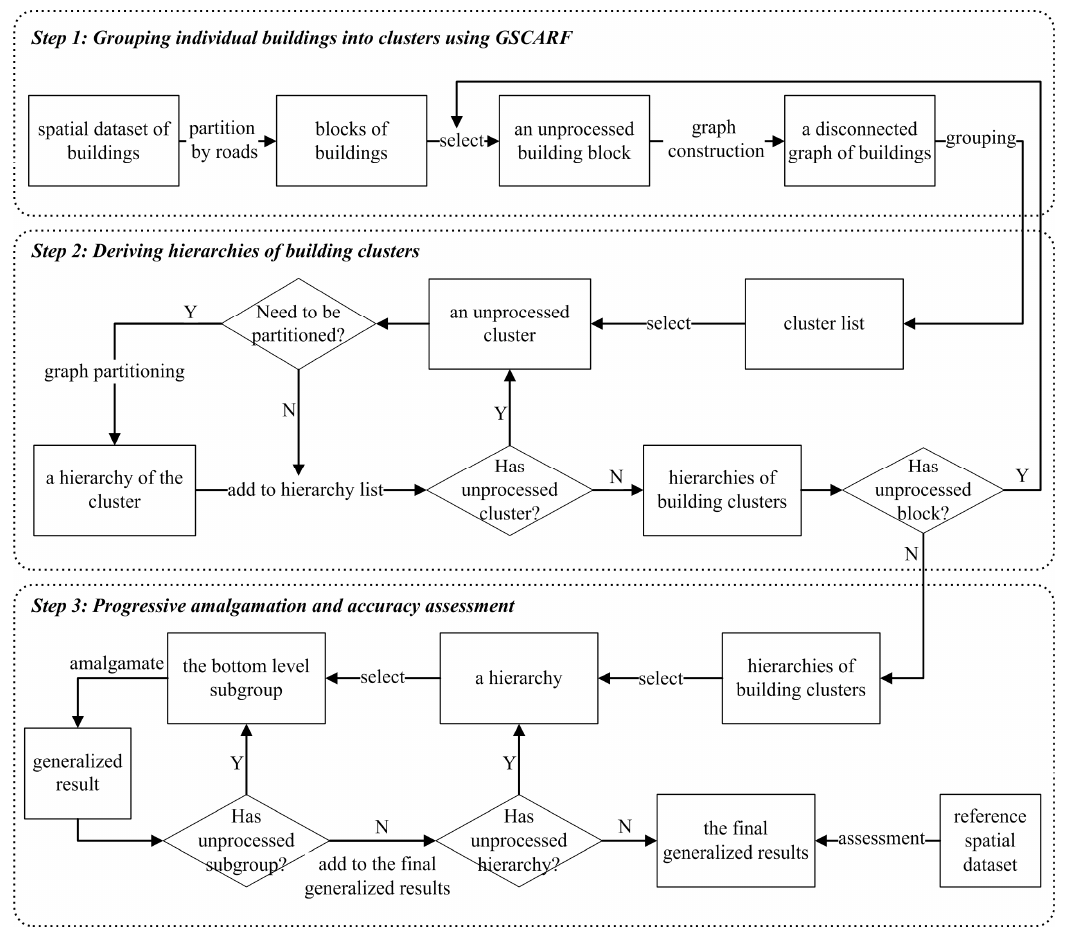
Figure 1. The overall framework for the progressive amalgamation of building clusters. GSCARF: graph-based spatial clustering application with random forest.